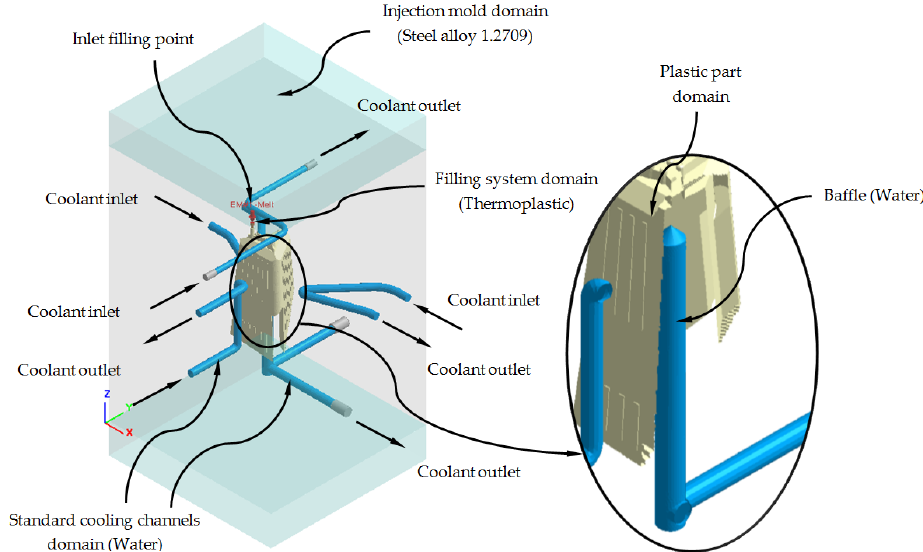
Figure 12. Materials and boundary conditions defined for the traditional cooling configuration.